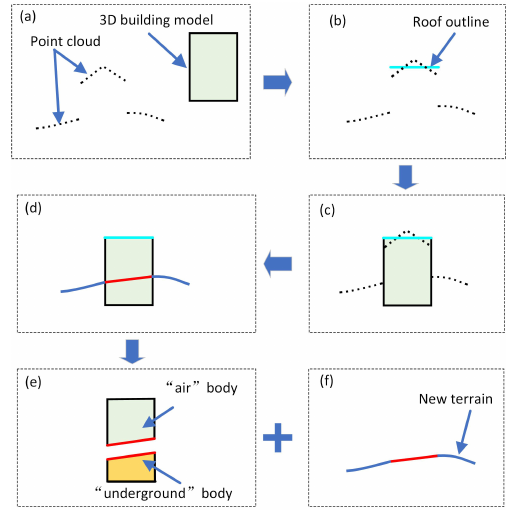
Figure 7. The process of modelling based on 3D building models and point clouds.